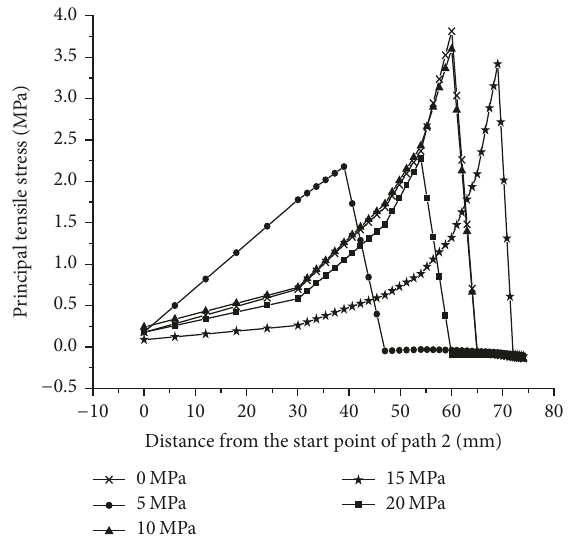
Figure 22: Comparison of the principal tensile stress generated along path 2 from corrosion-induced expansion when the dis- placement resulting from corrosion-induced expansion reaches 0.005